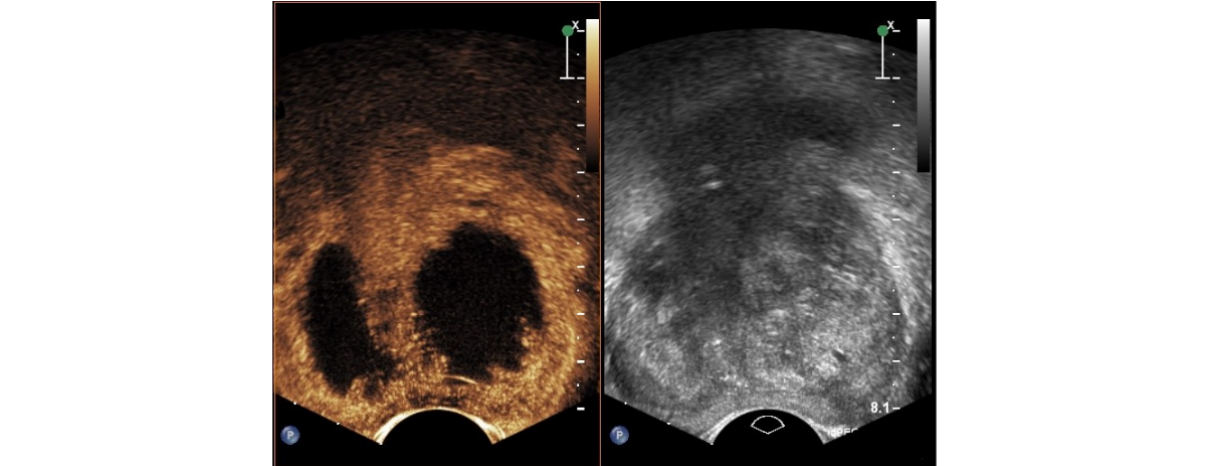
Figure 4. On the left the contract-enhanced ultrasound image of the prostate of the prostate 1 month following TPLA treatment, with dark areas corresponding with the treated areas. On the right the co-localized grey-scale